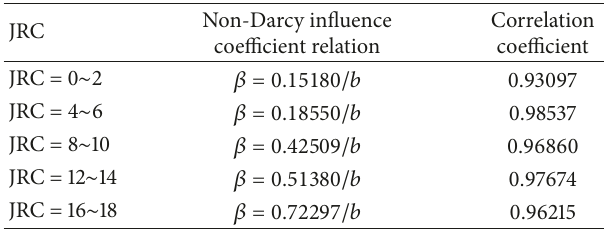
Table 3: The relationship between non-Darcy number and gap width under different joint